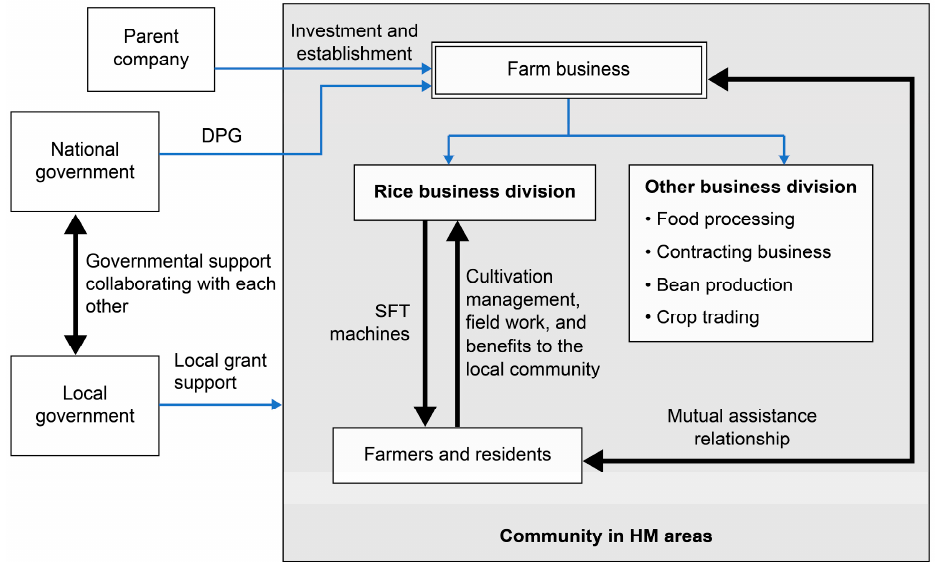
Figure 4. Diagram of the farm business model on introducing SFT to sustainable